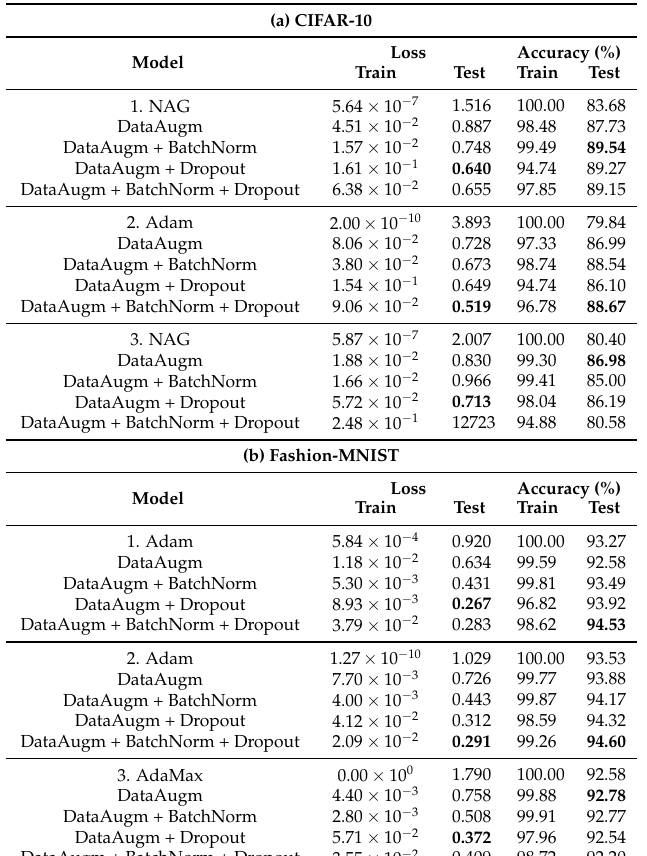
Figure 18. The effect of Data Augmentation on baseline models trained on Fashion-MNIST dataset. Table 9. Results obtained using Data Augmentation